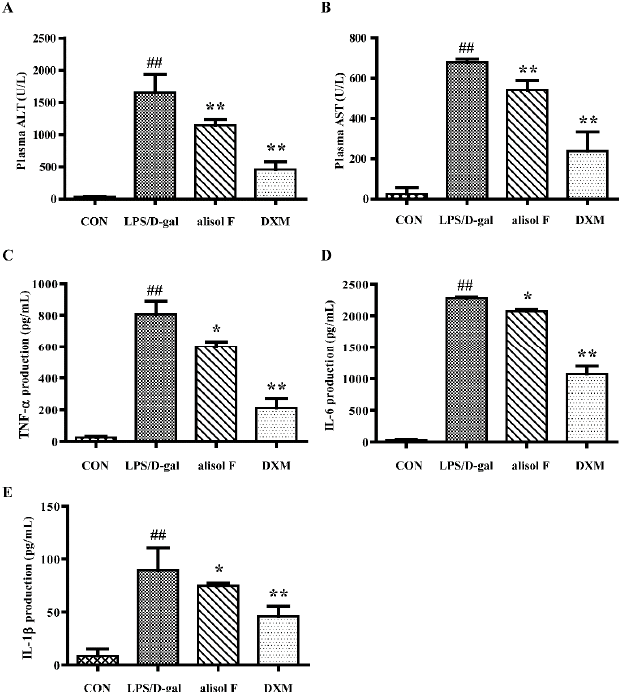
Figure 8. Alisol F alleviated LPS/ D -gal-induced hepatotoxicity. C57BL/6 mice were pretreated with alisol F (20 mg/kg), DXM (5 mg/kg) or vehicle for three days. After 30 min of the last treatment, mice exposed to LPS/ D -gal (LPS 40 μ g/kg, D -gal 700 mg/kg) except for control group. Serum were harvested for measured the production of alanine aminotransferase (ALT) and aspartate aminotransferase (AST) at 5 h after LPS/ D -gal exposure ( A , B ); Serum were harvested at 2 h after LPS/ D -gal treatment for measured the production of TNF- α ( C ), IL-6 ( D ), and IL-1 β ( E ) by using ELISA kits. The data represent the means ± S.E. of three independent experiments. ( ## p < 0.001 vs. control group; * p < 0.05, ** p < 0.001 vs. LPS/ D -gal group).